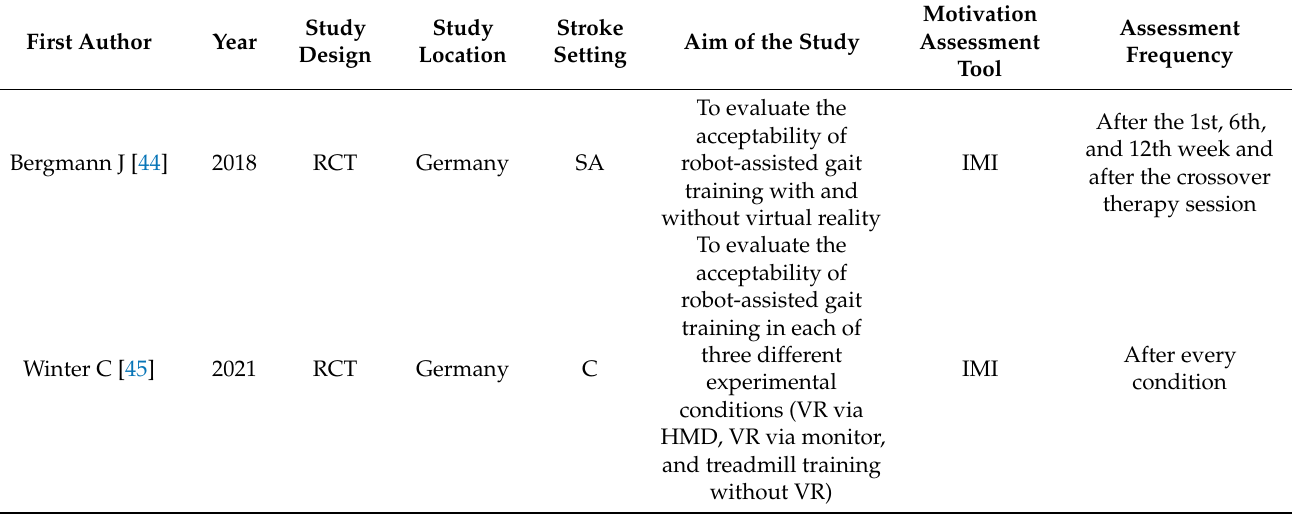
Table 2. Motivation-assessing interventional studies in stroke patients in rehabilitation setting.